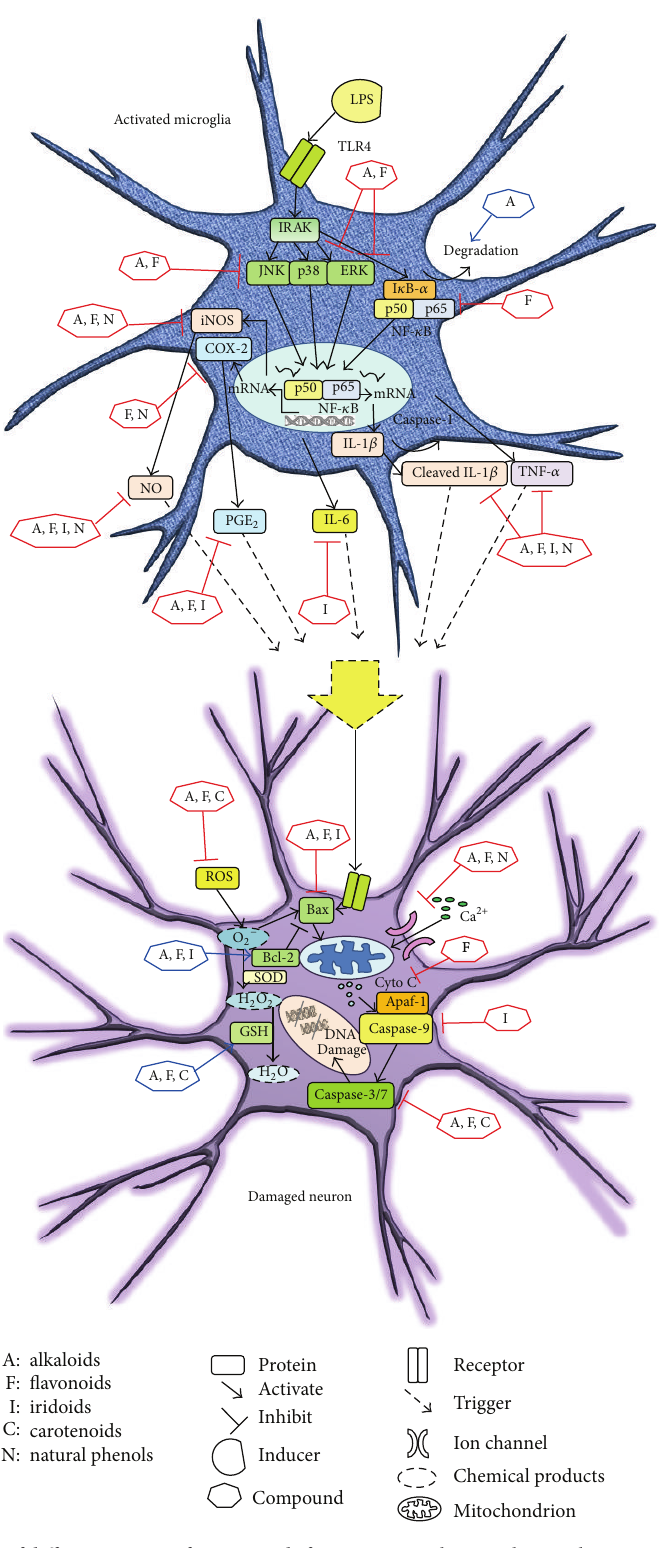
Figure 6: Summary of the effects of different groups of compounds from GUD on the signaling pathways involved in inflammatory responses in microglia and apoptosis in neuronal cells in neurodegenerative